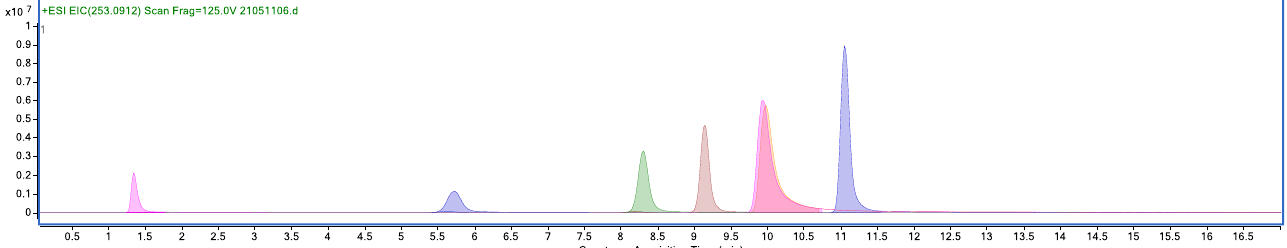
Figure 12. Excerpt chromatogram of standards (EIC) of 1 ppm CBZ, acridone, acridin, Oxo-CBZ, Epoxi-CBZ, 10-OH CBZ, malonic acid and 4-aminophenol. Table 1. Standards analyzed.